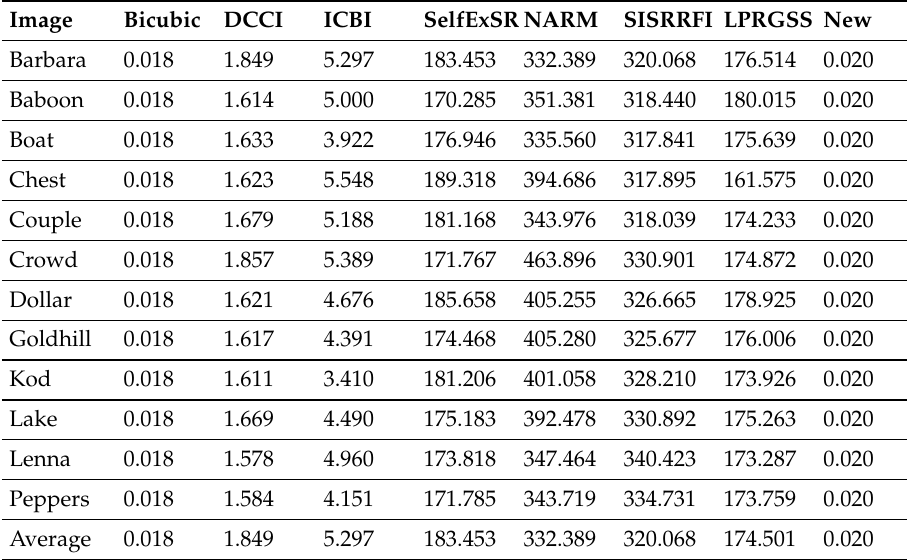
Table 3. Runtime of 12 images with 8 methods (Unit: